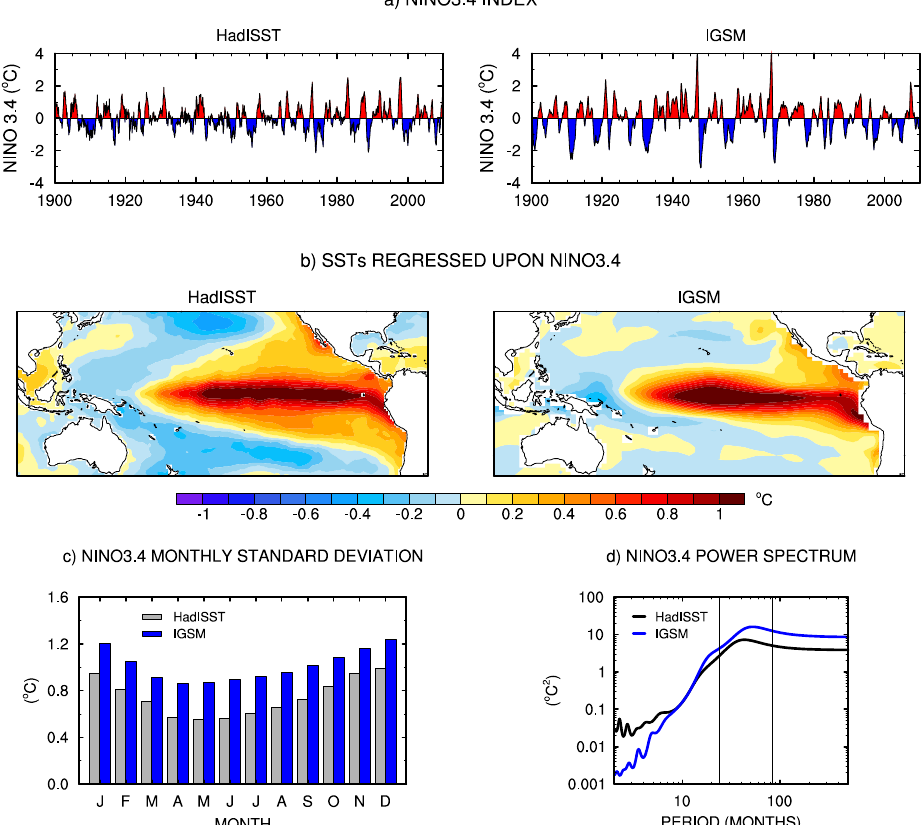
Fig. 11. (a) Nino3.4 index, defined as the average of sea surface temperature anomalies over the region 5 ◦ S–5 ◦ N and 170 ◦ W–120 ◦ W; (b) sea surface temperature regressed upon the Nino3.4 index; (c) monthly standard deviation of the Nino3.4 index; and (d) maximum entropy power spectrum of the Nino3.4 index for the IGSM, under median climate sensitivity, and for the HadISST over the 1901–2010 period. The vertical lines correspond to periods of 2 and